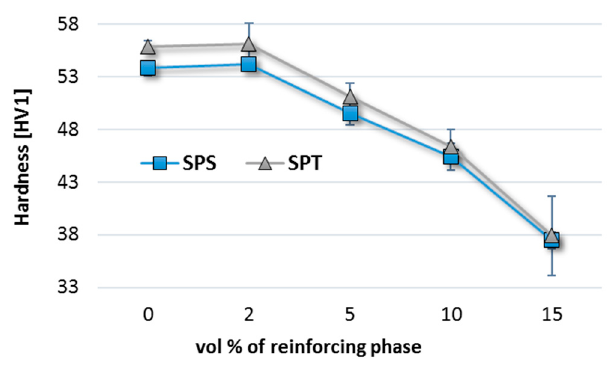
Figure 11. Vickers hardness of AA6061/MLG composites obtain in SPS and SPT process.